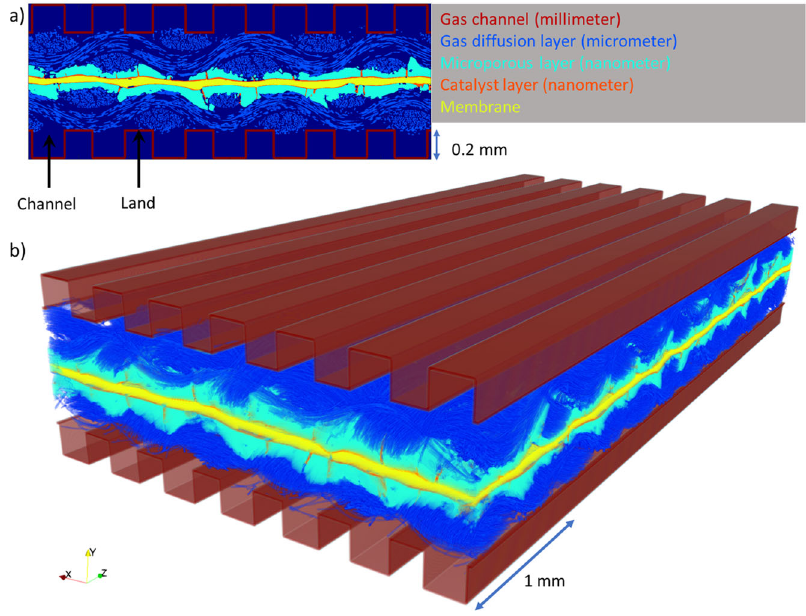
Fig. 1 | Thegenerated PEMFC domain in this study. a 2D and b 3D rendering of the segmented membrane electrodeassembly with arti fi cially overlayed fl owchannels. The gas channel and land contacting the GDL are